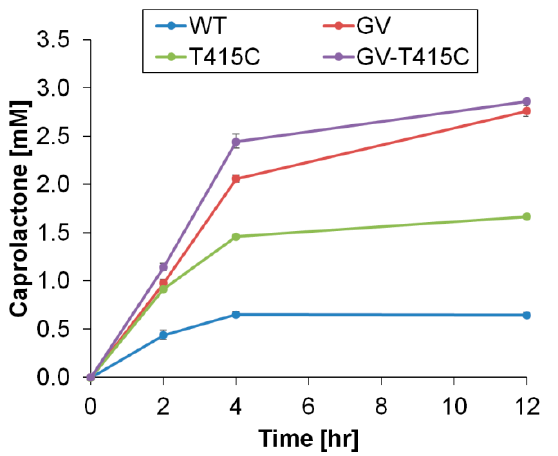
Figure 5. CHMO panel conversion of cyclohexanone to caprolactone in a standard reaction mixture (5 mM NADPH, 5 mM cyclohexanone, 50 mM sodium phosphate pH 7.7, 6 µg/mL purified protein). Reaction was monitored over 12 h at 37 °C. The variant obtained from this study, CHMO GV (red), supported improved conversion over WT CHMO (blue) and CHMO T415C (green). While WT CHMO activity diminished greatly over 4 h incubation and converted only ~10% of substrate available, both CHMO GV-T415C (purple) and CHMO GV retained consistent conversion during 4 h period and achieved ~50% conversion after 12 h incubation. Values are an average of three replicates, and the error bars represent one standard deviation.